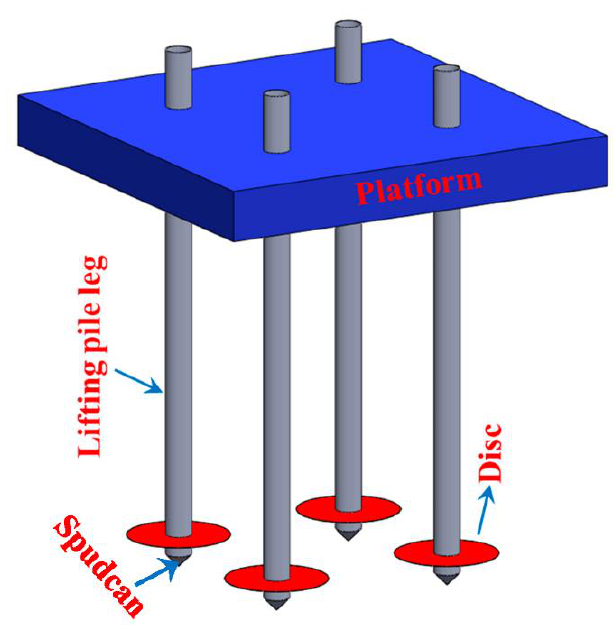
Figure 1. Schematic diagram of the geometric model for the jack-up offshore platform and its seabed foundation (unit: m). The labeled positions: A (115.95, 35, 50), B (118, 37.05, 50), C (120.05, 35, 50), D (145.95, 35, 50), E (148, 37.05, 50), F (150.05, 35, 50), and S (0, 50, 50), are several typical positions used for subsequent analysis of computational results.